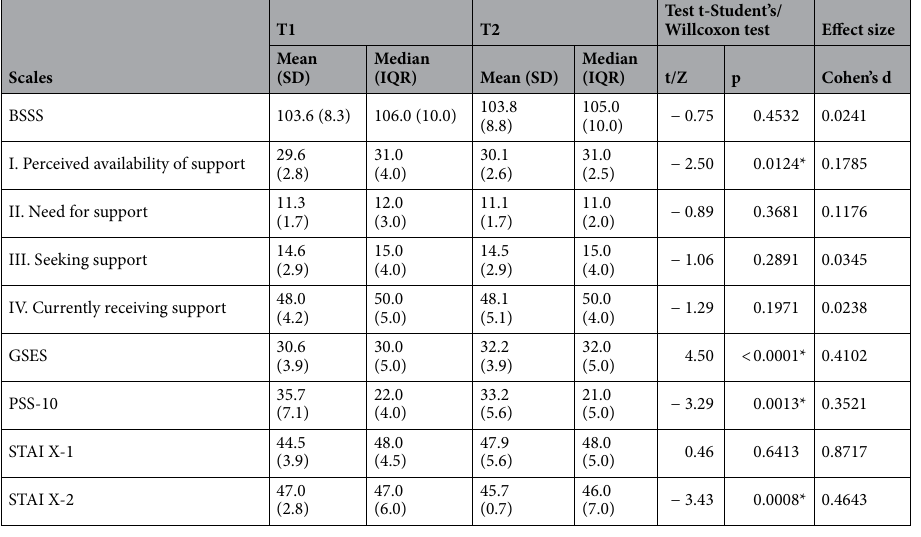
Table 2. The results of the BSSS (Wilcoxon test), GSES, PSS-10 and STAI (t-Student’s test) at initial (T1) and final (T2) studies. BSSS, Berlin Social Support Scales; GSES, General Self Efficacy Scale; PSS-10, Perceived Stress Scale; STAI X-1, The State-Trait Anxiety Inventory as a state; STAI X-2, The State-Trait Anxiety Inventory as a trait;T1, Initial results; T2, Final results; *p <